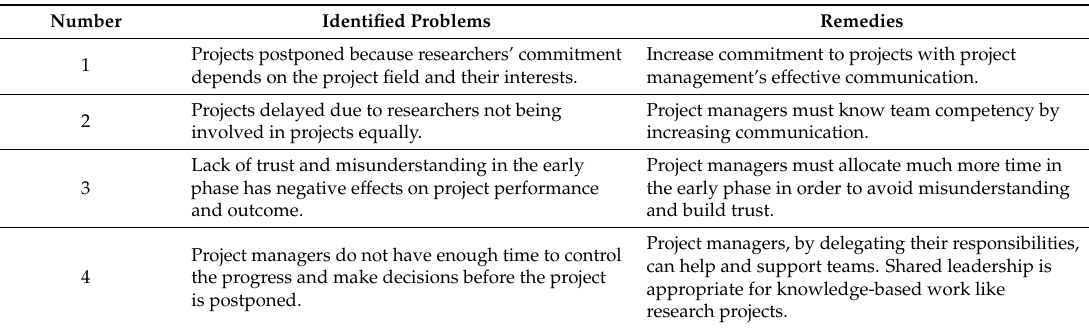
Table 1. Summary of possible remedies for